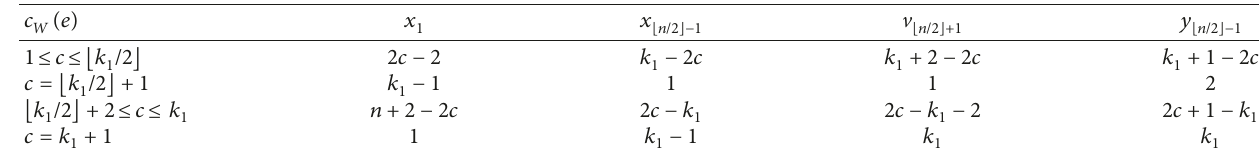
u c is c c , when